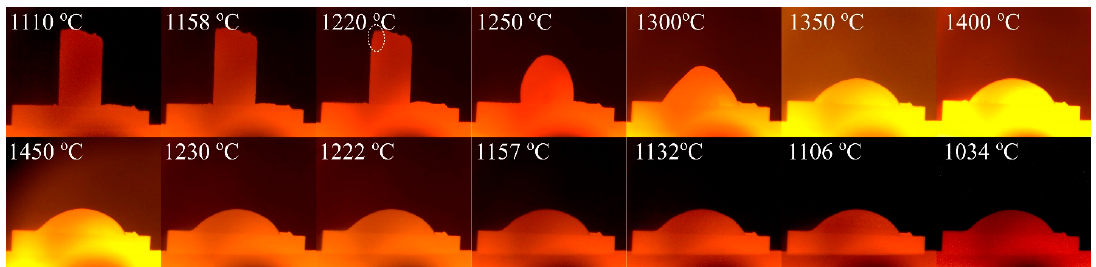
Figure 16. Images of Fe-26.38Si-9.35B droplets on the graphite substrate under vacuum in the sessile drop wettability test.